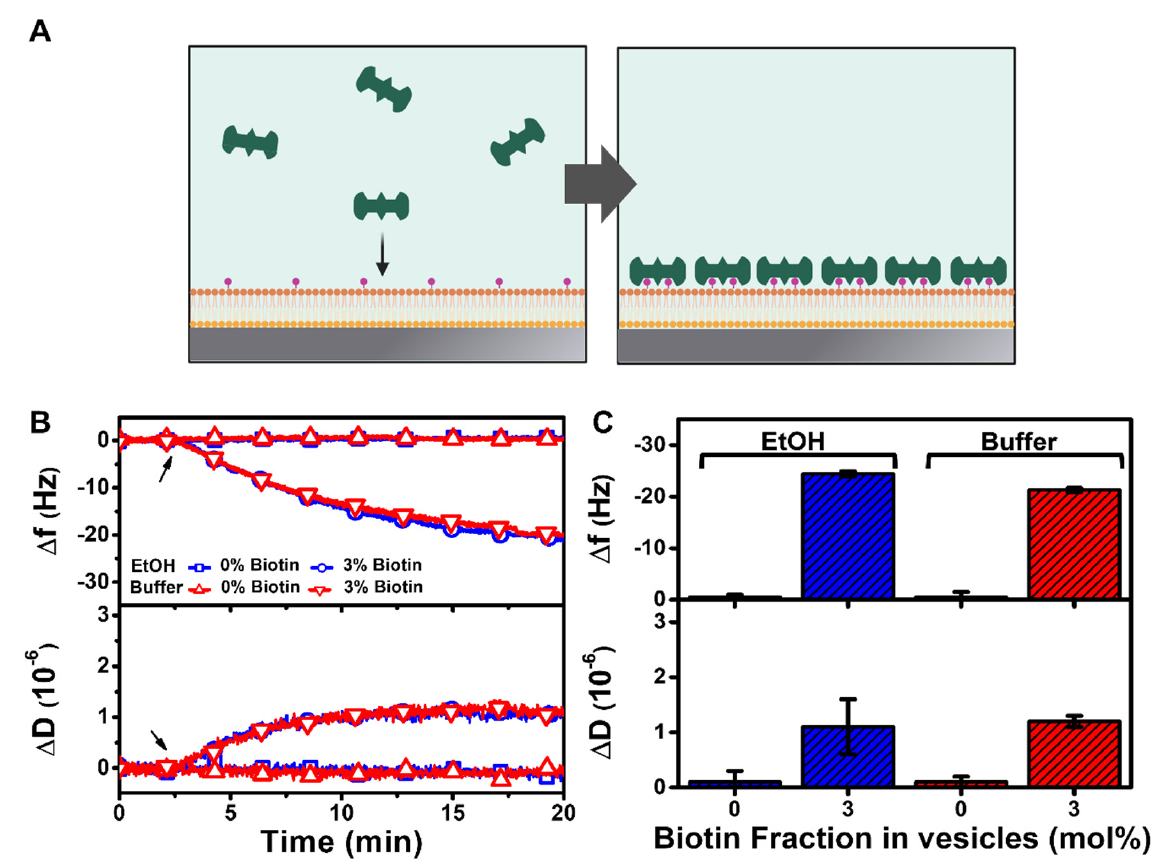
Figure 5. QCM-D tracking of streptavidin protein binding to HLB platform on a functionalized TiO 2 surface. ( A ) Schematic illustration of streptavidin binding to HLB platform containing biotinylated lipids. The platforms were fabricated using DOCP-functionalized TiO 2 surfaces that had been pre- pared using ethanol (EtOH) or buffer deposition protocols. ( B ) Time-resolved ∆ f and ∆ D signals are reported for streptavidin binding to HLB platforms containing 0 or 3 mol% biotinylated lipids. The arrow indicates the start of streptavidin addition. ( C ) Summary of final ∆ f and ∆ D shifts for strep- tavidin binding corresponding to data in panel ( A ). The data are presented as the mean ± standard deviation from n = 3 runs. When streptavidin was added to HLB platforms containing 3 mol% biotinylated lipids, there were large ∆ f shifts of around − 24 Hz along with moderate ∆ D shifts of around 1 × 10 − 6 , indicating rigid protein attachment (Figure 5B). In marked contrast, there were negligible ∆ f and ∆ D shifts for streptavidin binding to HLB platforms containing 0 mol% biotinylated lipid, verifying that protein attachment did not occur in the absence of biotinylated lipid receptors in the HLB platform. For the HLB platform containing 3 mol% biotinylated lipid that was prepared using the ethanol deposition protocol, the final ∆ f and ∆ D shifts for streptavidin addition were around − 24.4 ± 0.5 Hz and 1.1 ± 0.5 × 10 − 6 , respectively (Figure 5C). Similar measurement responses corresponding to final ∆ f and ∆ D shifts of around − 21.3 ± 0.4 Hz and 1.2 ± 0.1 × 10 − 6 , respectively, were also recorded for the HLB platform containing 3 mol% biotinylated lipid that was prepared using the buffer deposition protocol. These findings support that the HLB platform is suitable for selective attachment of streptavidin protein receptors and also prevents nonspecific adsorption of proteins in other cases due to the antifouling properties of the HLB